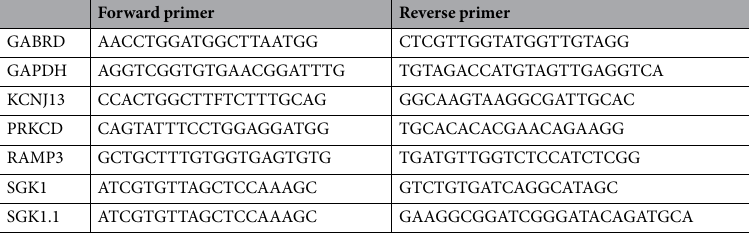
Table 4. PCR primers for RT-PCR